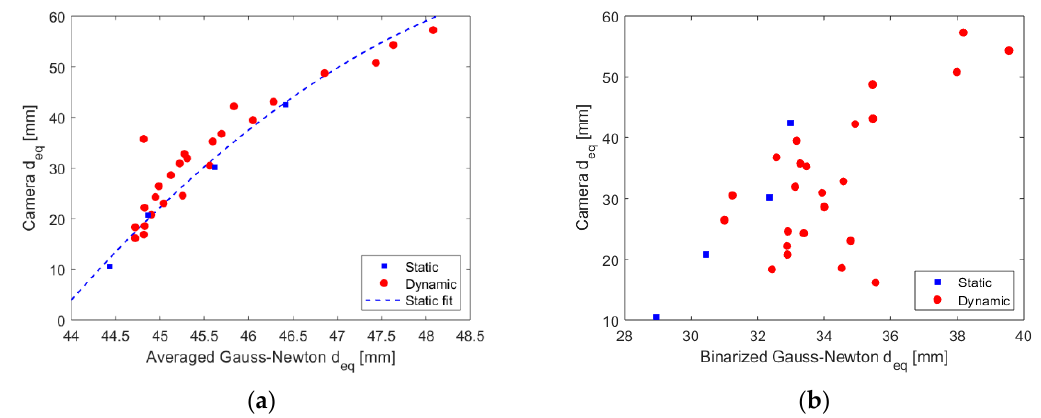
Figure 16. Average equivalent diameters obtained using the camera plotted against the Gauss-Newton reconstruction scheme for the static and dynamic experimental points. ( a ) Averaged Gauss-Newton scheme. The blue dashed line of the graph is obtained by fitting the 4 static points but plotted for the entire range of dynamic data for comparison. ( b ) Binarized Gauss-Newton scheme. As the dynamic data does not follow a clear trend in the Figure, no fit based on the static measurements is presented.